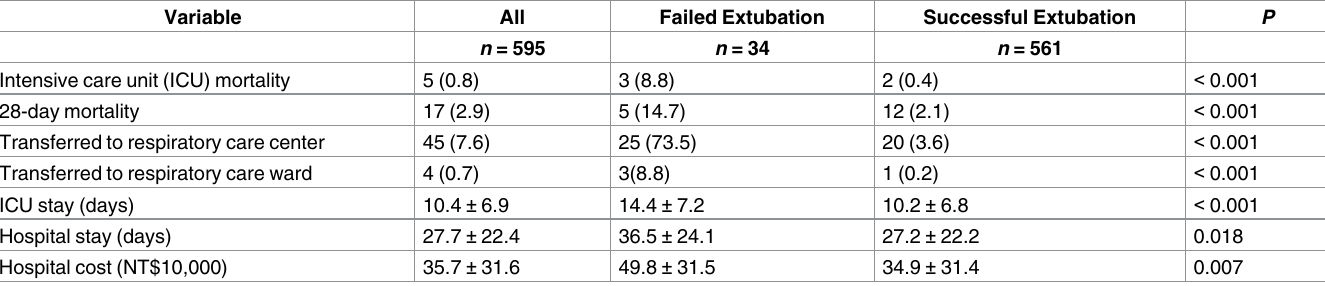
Table 3. Outcomes of Failed and Successful Extubation